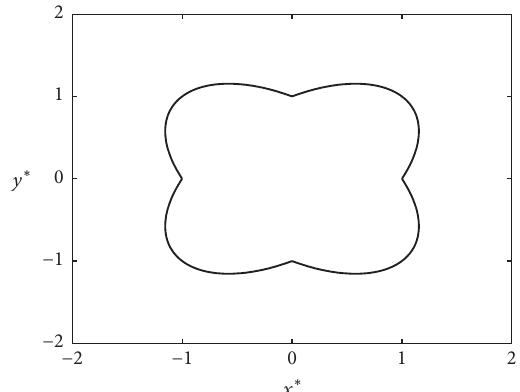
Figure 1: Systems with uncountable equilibria in which there has been an increasing interest in discovering different shapes of closed curve equilibrium.